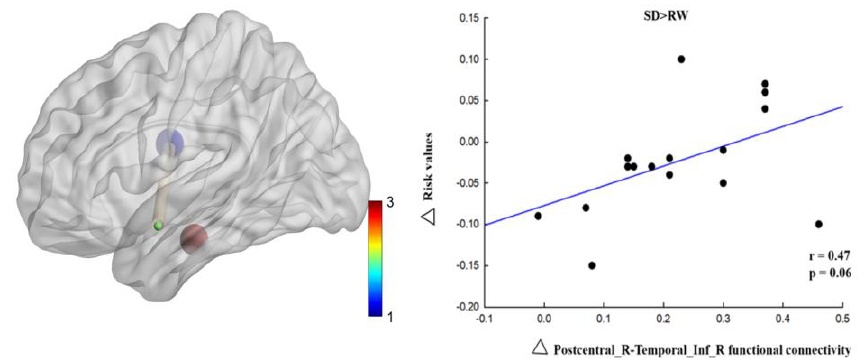
Figure 6. Functional connectivity changes correlated with risk value changes following sleep deprivation. Scatter plots show the relationship between right postcentral and right inferior temporal functional connectivity changes and risk value changes following sleep deprivation. Corresponding functional connectivity is illustrated to the left, beside each scatter plot, in which blue represents right postcentral (69, − 6, 21), red represents right inferior temporal (48, − 18, − 21) and green represents left middle temporal ( − 51, 0, − 15). SD, sleep deprivation; RW, rested wakefulness; R, right; Inf, inferior.